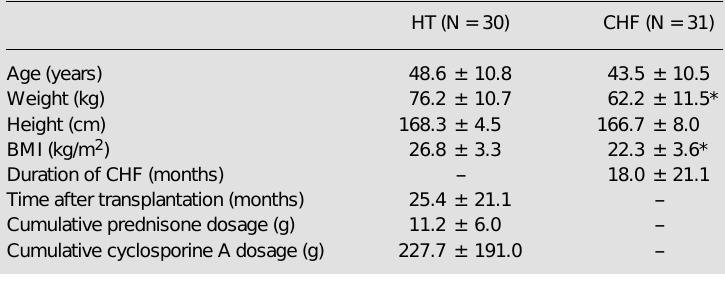
1 - Clinical characteristics of heart transplant (HT) recipients and chronic heart failure (CHF) patients. Data are reported as means ± SD. BMI, Body mass index. *P<0.001 versus HT (Mann- Whitney and Student t